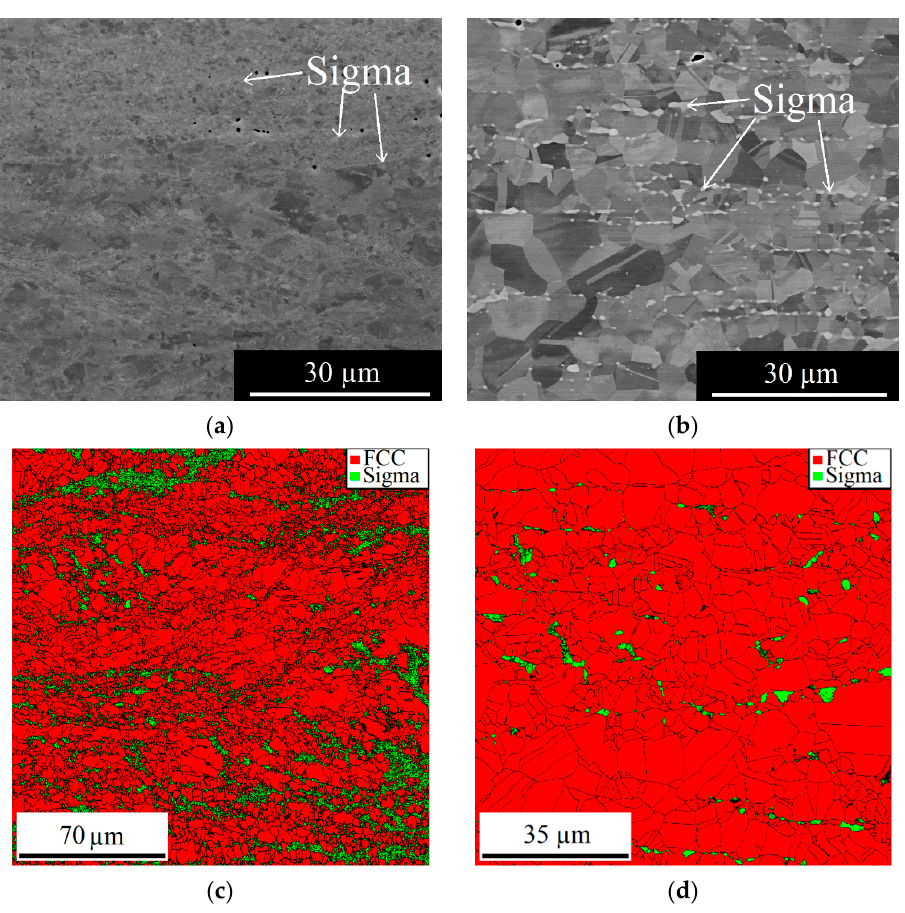
Figure 4. Microstructure of the N0 alloy after cold rolling and annealing at 700 °C ( a , c ) and 900 °C ( b , d ): SEM-BSE images—( a , b ), EBSD phase maps—( c , d ).